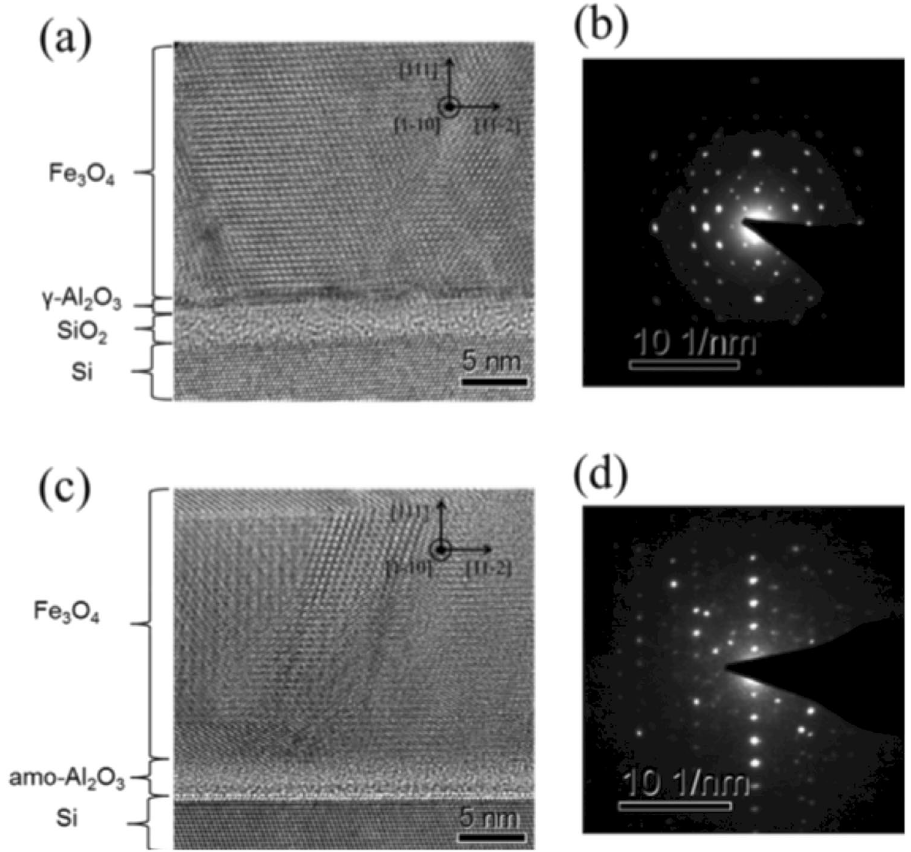
Figure 4. TEM observation: ( a ) Cross-section TEM image and ( b ) electron diffraction pattern of Si(111)/ γ - Al 2 O 3 /Fe 3 O 4 in EPI taken along the [1-10] axis zone, ( c ) Cross-section TEM image and ( d ) electron diffraction of Si(111)/amo-Al 2 O 3 /Fe 3 O 4 in AMO taken along the [1-10] axis